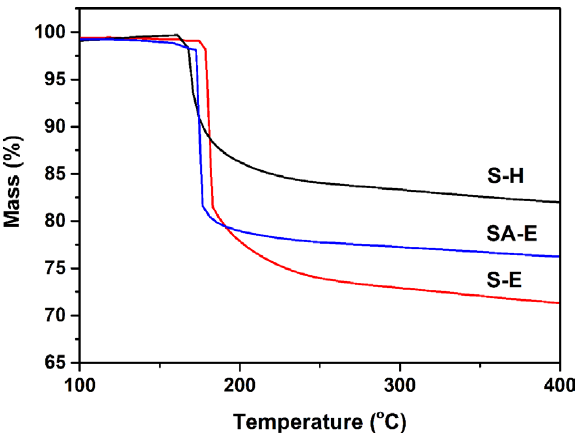
Figure 8. TG curves of as - synthesized Samples S - H , S - E, and SA - E .